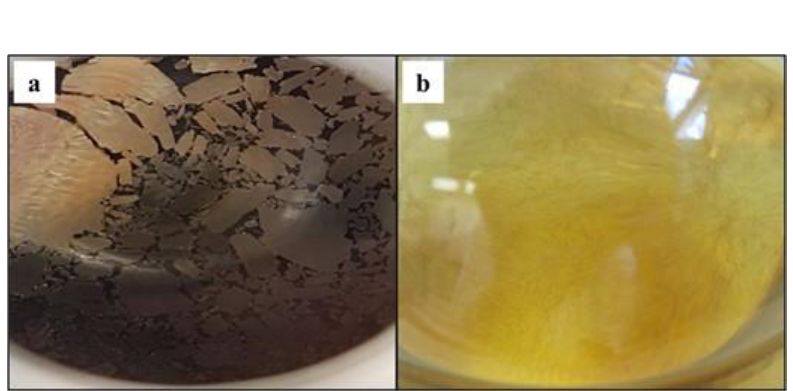
Figure 3. Interface of NH 3(g) (3.3% v/v) headspace and iron salts solution (2:1 Fe 2+ :Fe 3+ ) for total iron concentrations (a) 10 mM and (b) 3.8 mM.